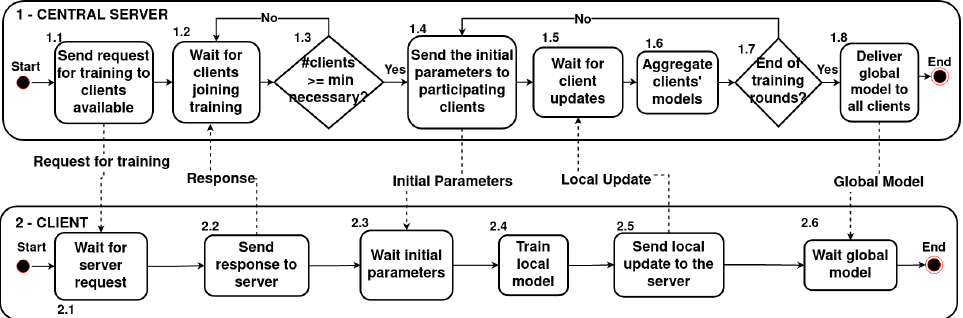
Figure 2. Flowchart of the training process in